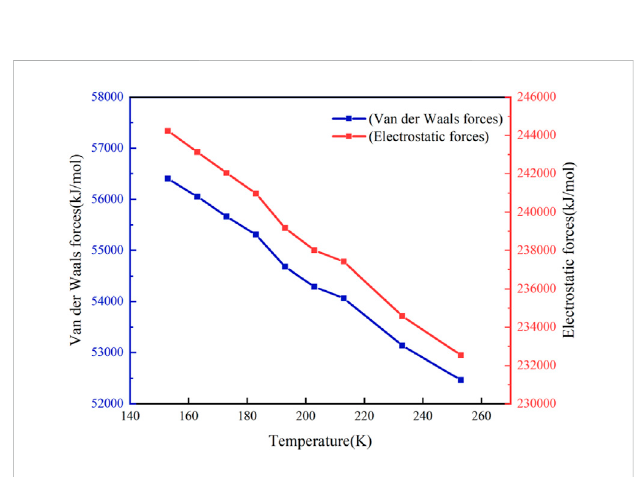
FIGURE 9 Van der Waals and electrostatic forces at different